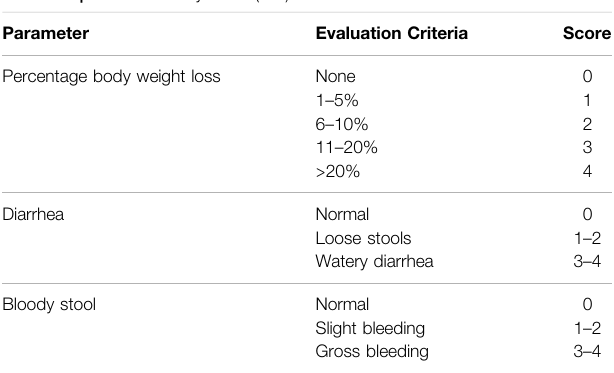
TABLE 2 | Disease activity index (DAI) criteria. TABLE 3 | Macroscopic damage index (MDI) criteria.